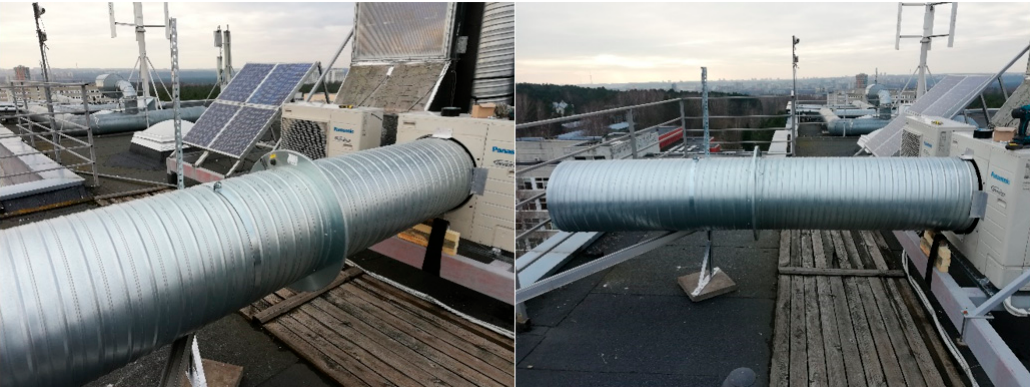
Figure 2. The experimental setup on the roof of VILNIUS TECH.